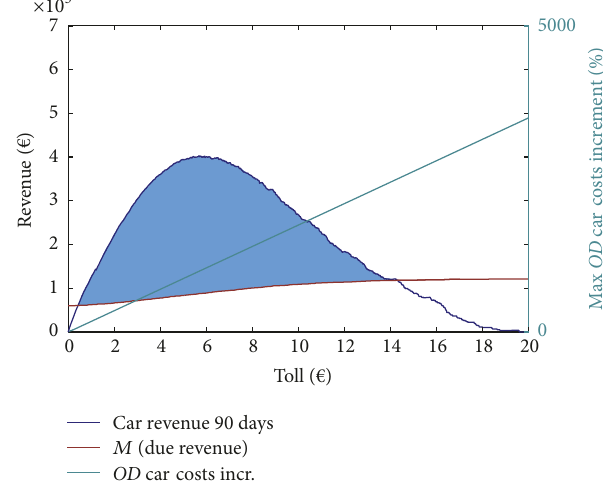
Figure 12: Number of days of operation of the pricing